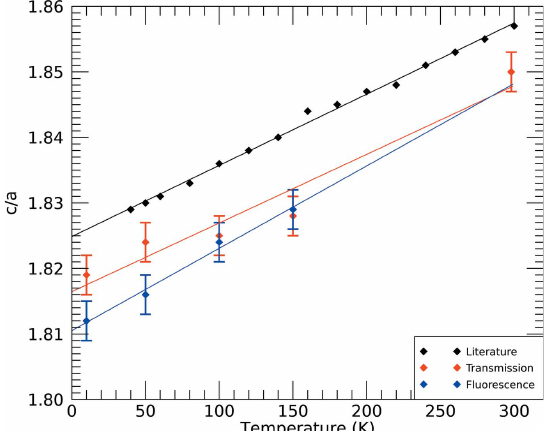
Figure 23 Optimized (cid:5) 2 for c / a from the grid search and compared with the r literature (Nuss et al. , 2010). An uncertainty of 0.003 follows the error analysis, step size and the uncertainty of the quadratic (Fig. 12, Table 3).